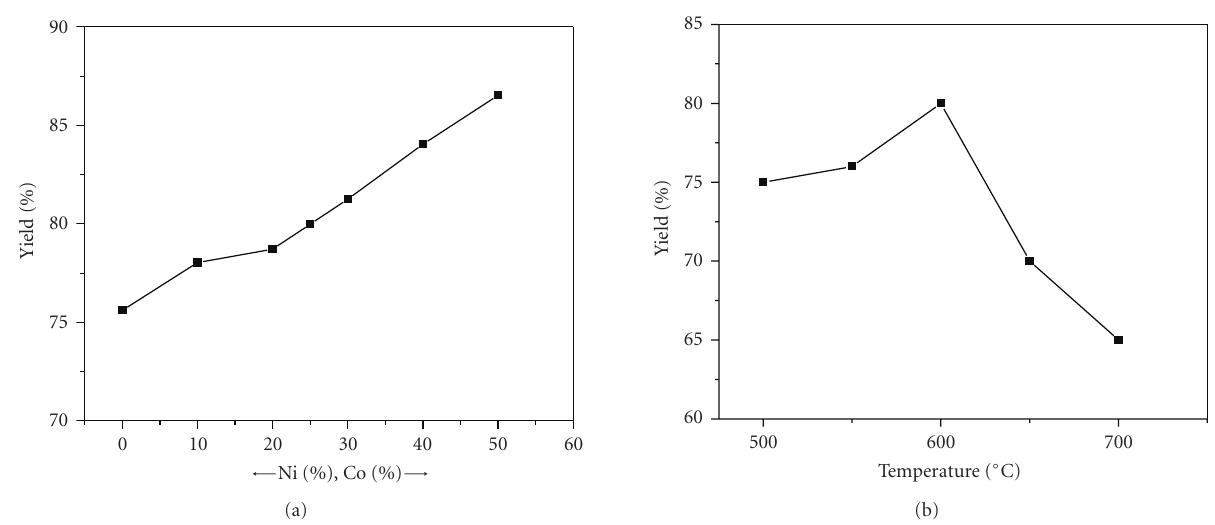
Figure 1: CNT yield as a function of (a) Co-Ni catalysts loading (Wt%) during 60 minutes growth time with flow of H 2 + C 2 H 2 (100 + 15mL/min) at 600 ◦ C, (b) reaction temperature of 25% Co + 25% Ni catalyst on MgO support.